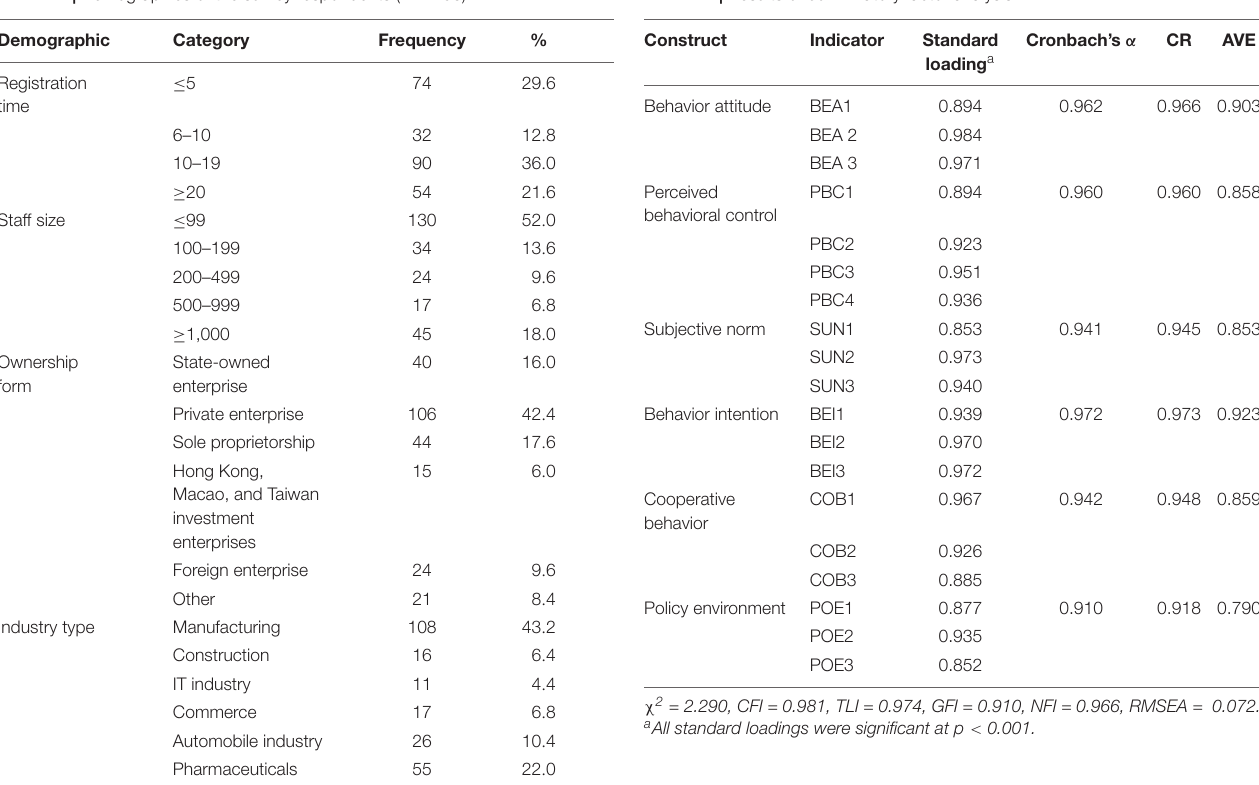
TABLE 1 | Demographics of the survey respondents ( N = 250). TABLE 2 | Results of confirmatory factor